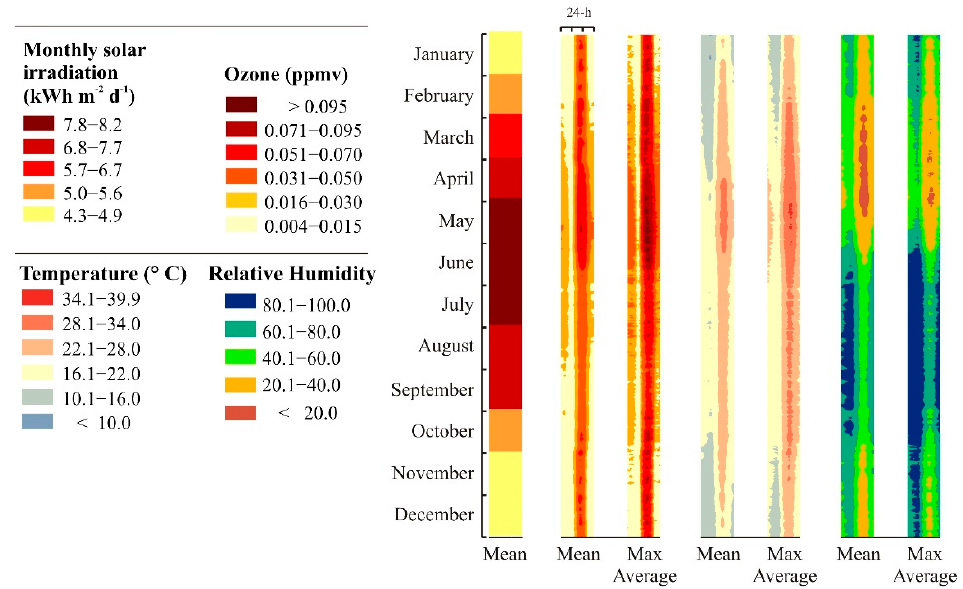
Figure 2. Normal ozone concentrations and climatology of the temperature and humidity for the period of 1996 to 2019 compared with the monthly average potential solar irradiation. Adapted with permission from ref. [25]. Ojeda-Castillo et al., 2018.